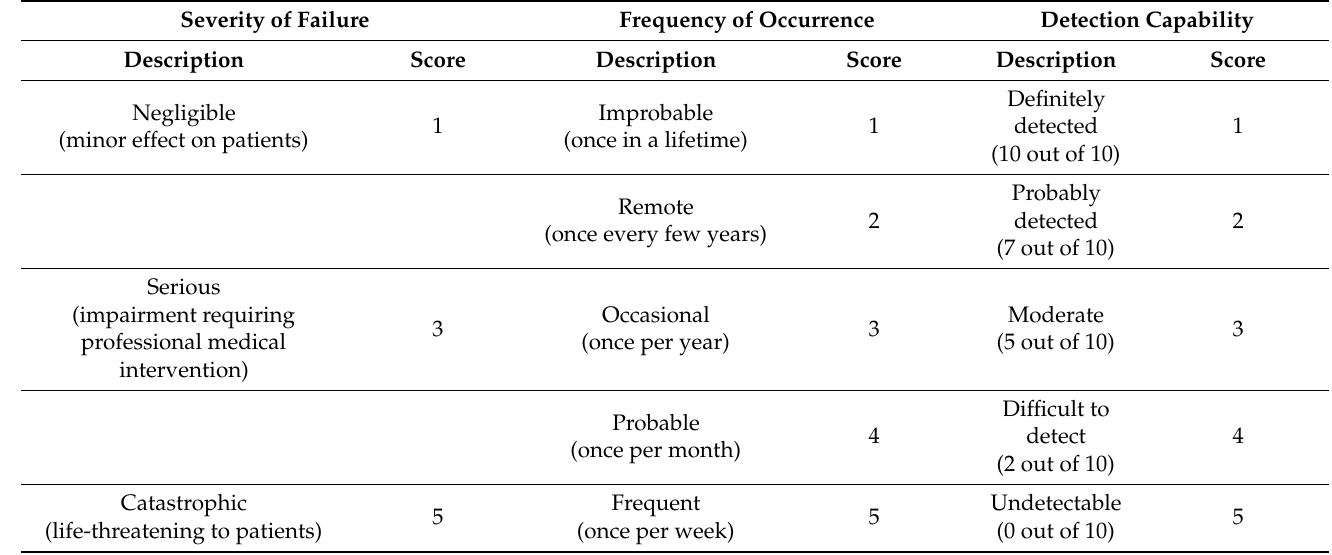
Table 1. The scoring system of each component for risk priority number